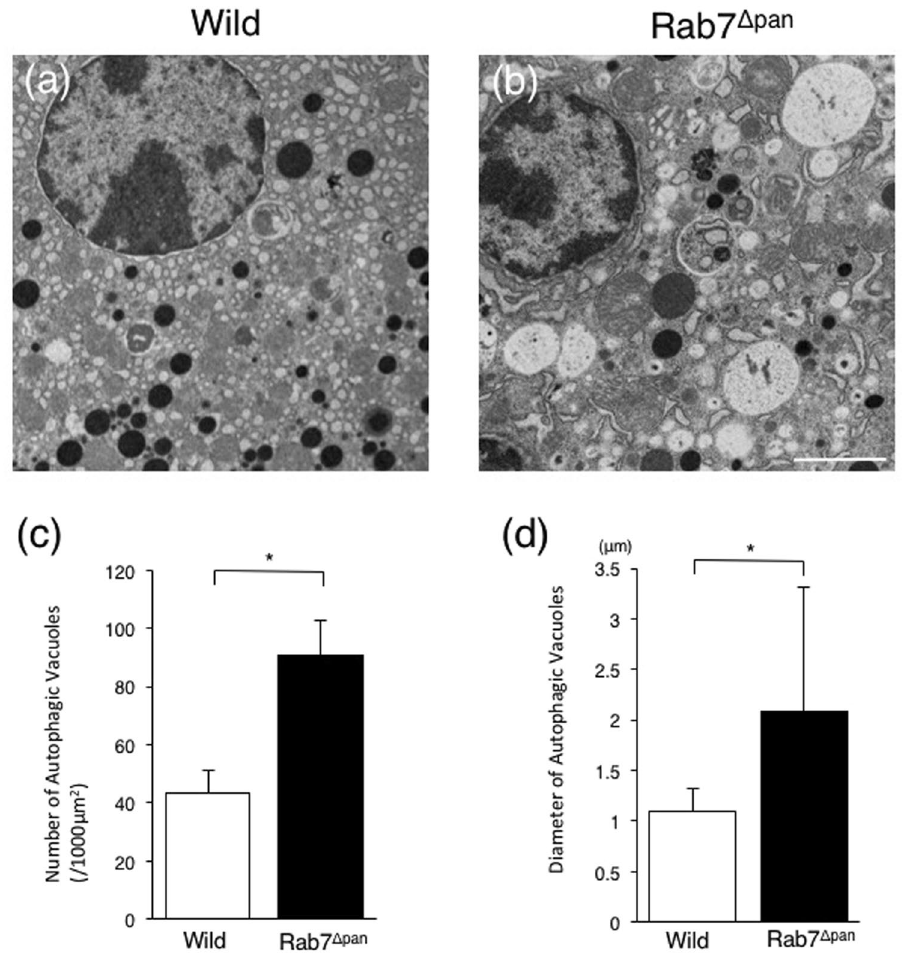
Figure 9. Comparison of autophagic vacuoles formed during caerulein-induced acute pancreatitis between Rab7 Δ pan and wild mice. ( a , b ) EM images of wild ( a ) and Rab7 Δ pan ( b ) mouse pancreases with caerulein- induced acute pancreatitis. Scale Bar: 2 µ m. ( c , d ) EM comparison of the number of autophagic vacuoles ( c ) and the diameter of autophagic vacuoles ( d ) formed under conditions of pancreatitis between control and Rab7 Δ pan mice. For each count, at least 100 images from 3 mice were quantified. * P <